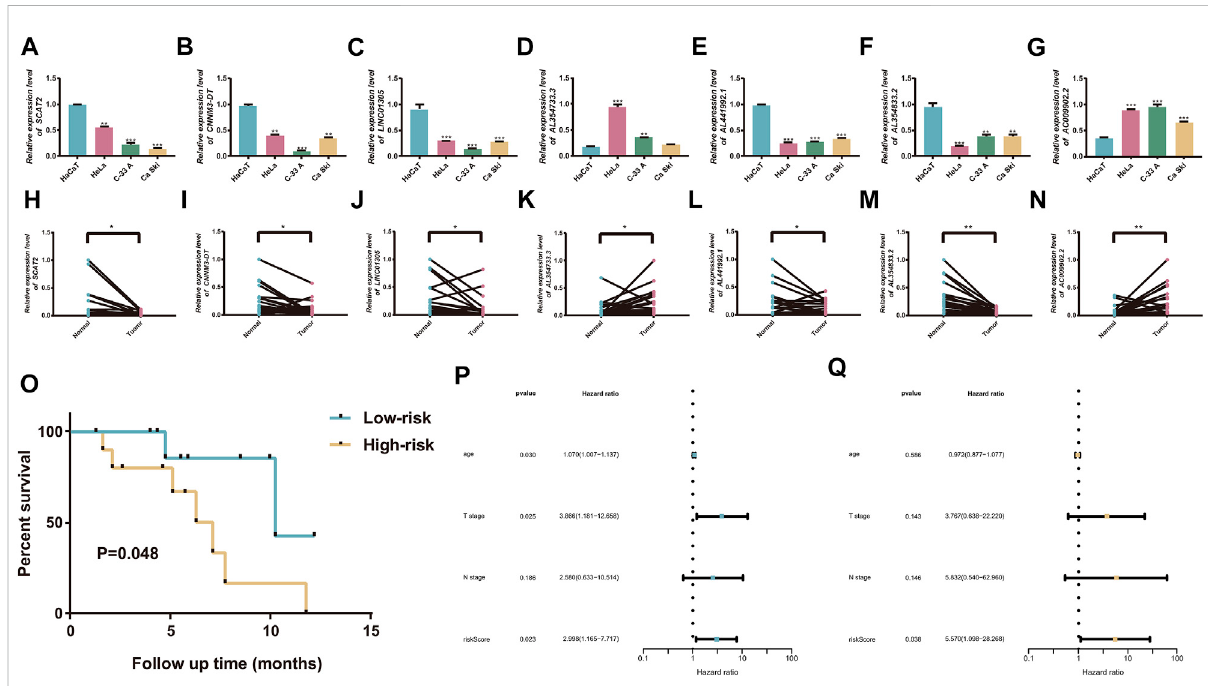
FIGURE 10 Validation of the cuproptosis-related prognostic signature. (A – G) Comparison of the expression of seven candidate lncRNAs between cervical tumor and normal cells. (H – N) twenty cercival cancer and matched adjacent normal tissues. (O) K-M curves exhibited that the RS was signi fi cantly associated with the overall survival. (P) Univariate Cox regression analysis demonstrated that the signature and T stage were signi fi cantly associated with prognosis. (Q) Multivariate Cox regression analysis revealed that RS could function as an independent factor in CC. * p < 0.05, ** p < 0.01, and *** p <